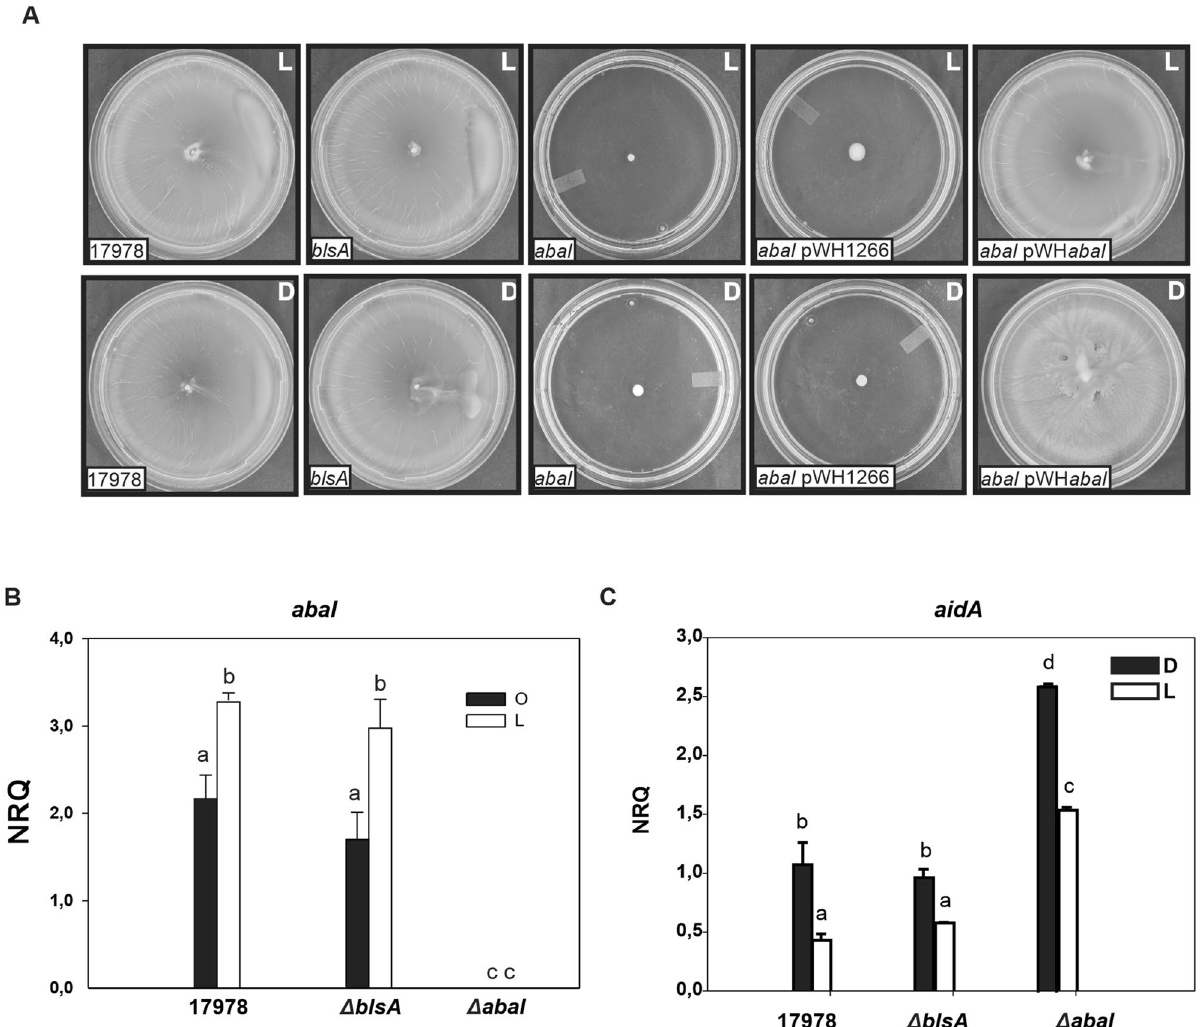
pWH1266 plasmid or the abaI -complementing plasmid pWHAbaI were inoculated on the surface of motility plates. Plates were inspected and photographed after incubation in darkness (D) or in the presence of blue light (L) at 37 °C. Representative results of three independent experiments are shown. ( B , C ) abaI and aidA expression is modulated by light in A. baumannii at 37 °C. Estimation by qRT-PCR of the expression levels of the gene coding for an acyl homoserine lactone synthase, abaI ( B ), and the gene encoding a lactonase, aidA ( C ), in cells recovered from motility plates inoculated with ATCC 17978 wild-type, ∆blsA and ∆abaI incubated at 37 °C under blue light (L) or in the dark (D). The data shown are the mean and standard deviation of normalized relative quantities (NRQ). Different letters indicate significant differences as determined by ANOVA followed by Tukey’s multiple comparison test ( p < 0.05). Representative results of three independent experiments are